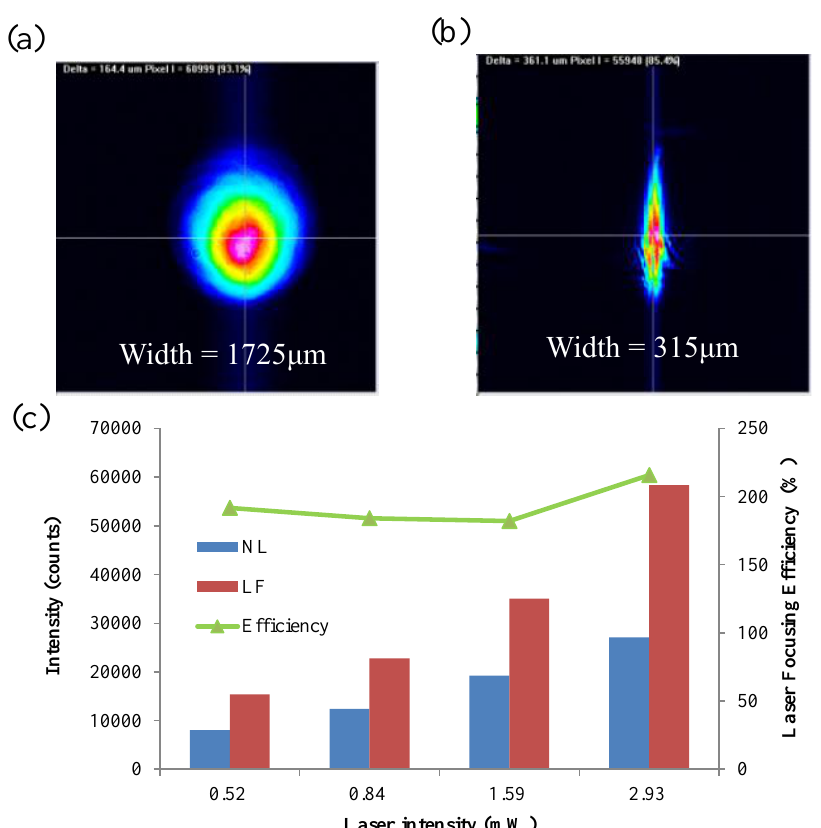
Figure 5. Beam profile images ( a ) without lens (NL); and ( b ) with laser focusing lens (LF); ( c ) Intensities of original and focused laser beam, and the focusing efficiency of the proposed